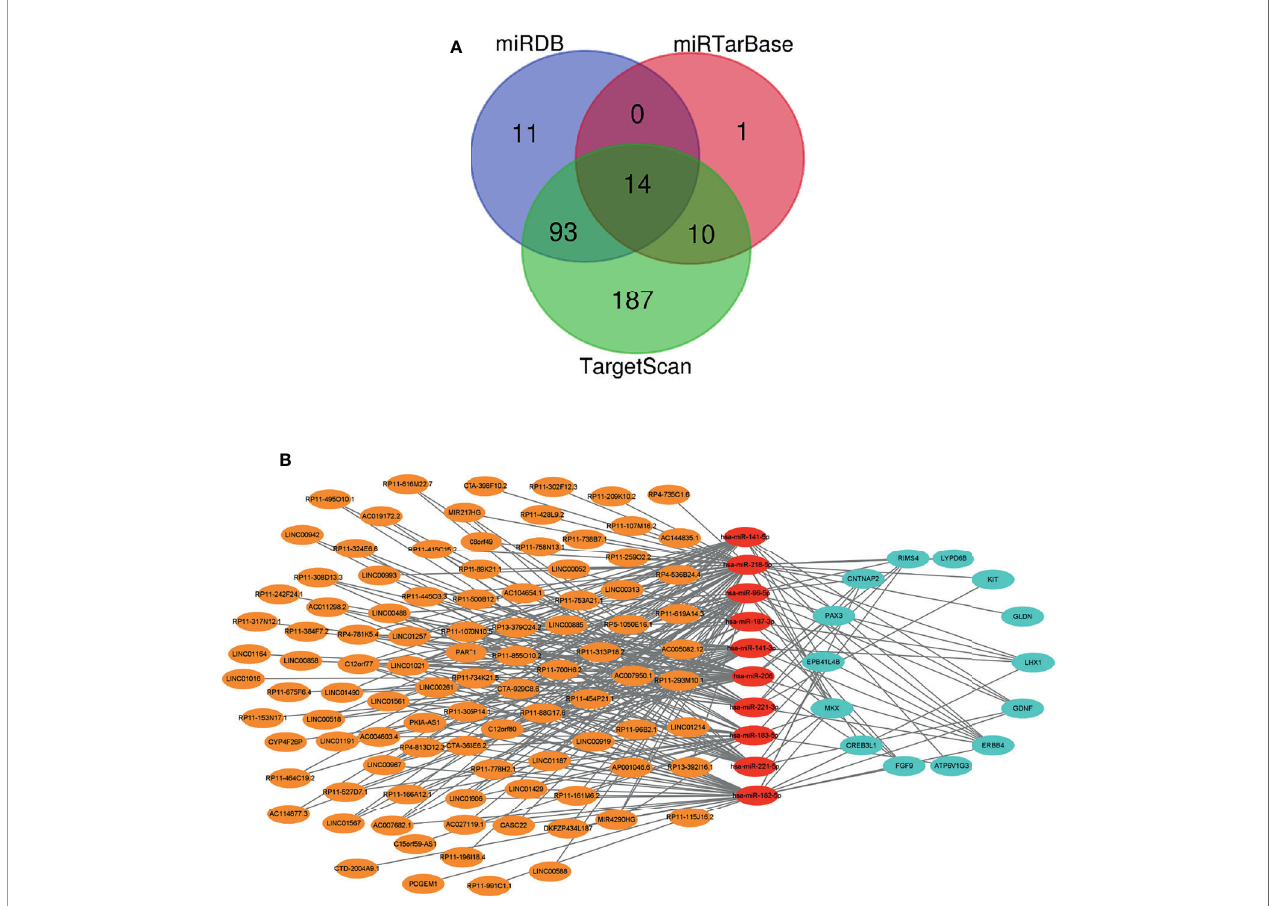
FIGURE 2 | A ceRNA network is created. (A) A Venn diagram showing the miRNA – mRNA interaction as predicted based on three databases. (B) A diagram showing the established ceRNA network. Orange, red, and blue circles represent DE-lncRNAs, DE-miRNAs, and DE-mRNAs, respectively. Gray lines represent interactions among lncRNAs, miRNAs, and mRNAs. ceRNA, competing endogenous RNA; DE-lncRNAs, differentially expressed long non-coding RNAs; DE-miRNAs, differentially expressed microRNAs; DE-mRNAs, differentially expressed messenger